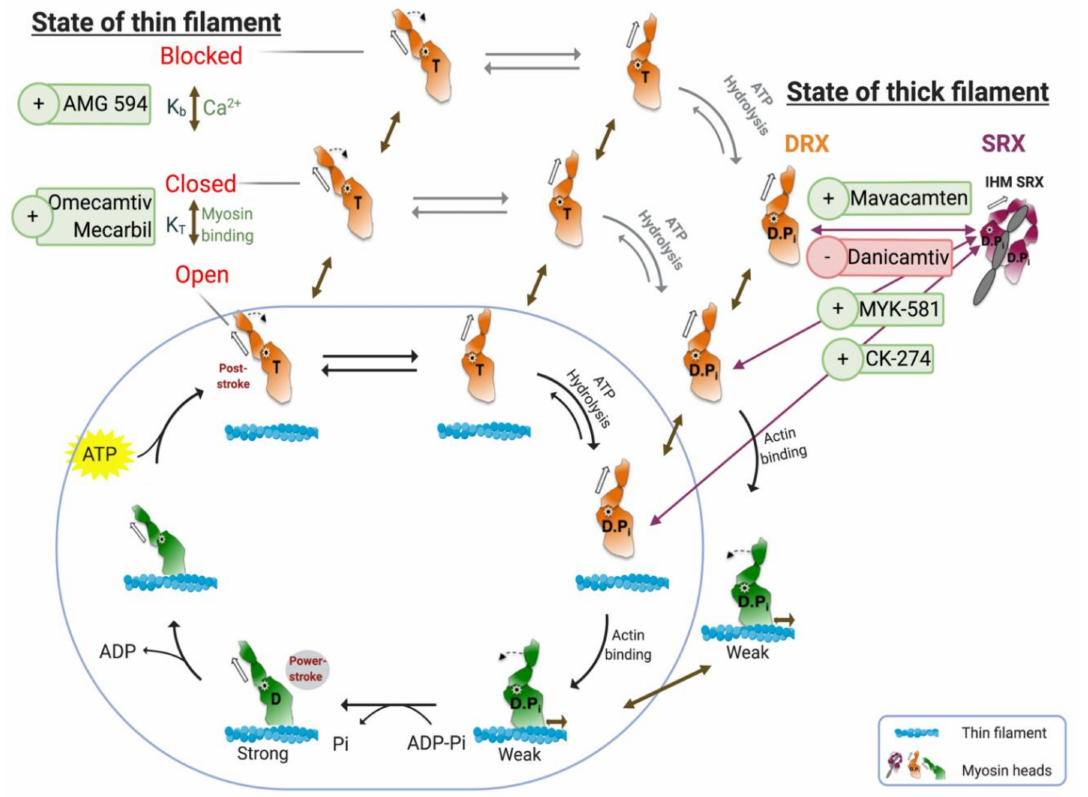
Figure 3. The chemomechanical crossbridge cycle and its regulation via troponin–tropomyosin (thin filament state) and super-relaxed / disordered-relaxed (SRX / DRX) equilibrium. The crossbridge is representedinthebluecircle. Theavailabilityofactin-bindingsitesisregulatedbythestateofthinfilament (top left). The equilibrium between blocked (no myosin bound) and closed (weak myosin-binding) is controlled by Ca 2 + . Myosin heads regulate the closed-open state in a cooperative fashion. Only thin filament in open state can participate in the chemomechanical cycle. Two small molecules that interact with both transitions are illustrated. The availability of myosin heads is regulated by the SRX / DRX equilibrium, and only myosin heads in DRX can be part of the crossbridge cycle. Four small molecules can regulate the transition, as shown. Figure was created by using Biorender.com as a modified version from References